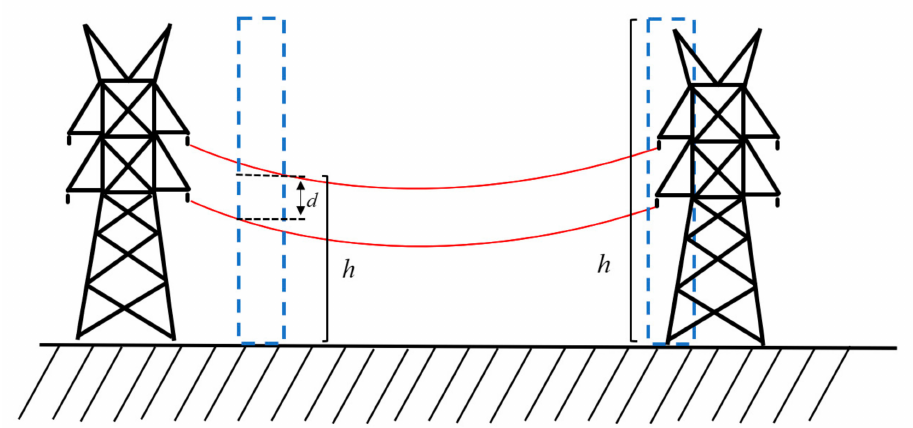
Figure 6. A schematic diagram of tower detection. The h represents the HGS of point clouds in the moving window, and d represents the biggest height gap in the moving